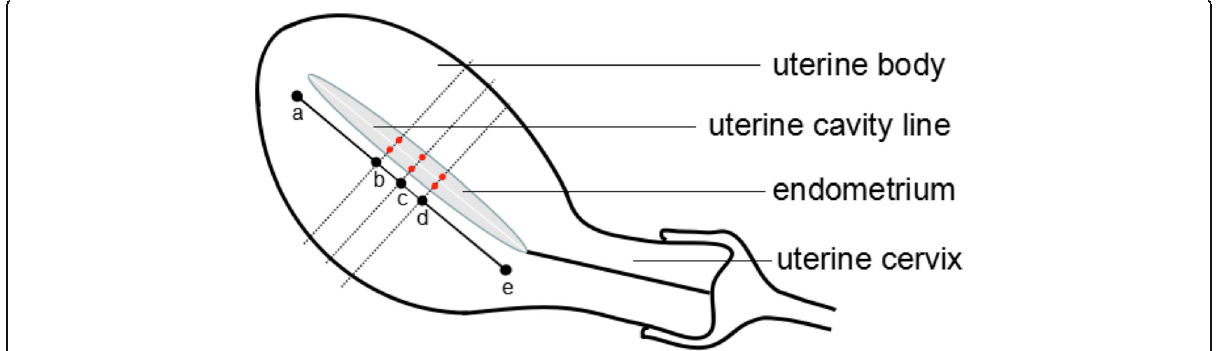
Fig. 1 Sites of endometrium for the measurement of endometrial elasticity by SWE. Notes: Line ae and uterine cavity line are parallel and have the same length; the three dotted lines are vertical to the line ae and endometrial line; point c is the middle point between point a and point e; point b localizes 0.5cm away from the point c (close to a); point d localizes 0.5cm away from the point c (close to e). Red dots represent the six sampling sites for SWE.